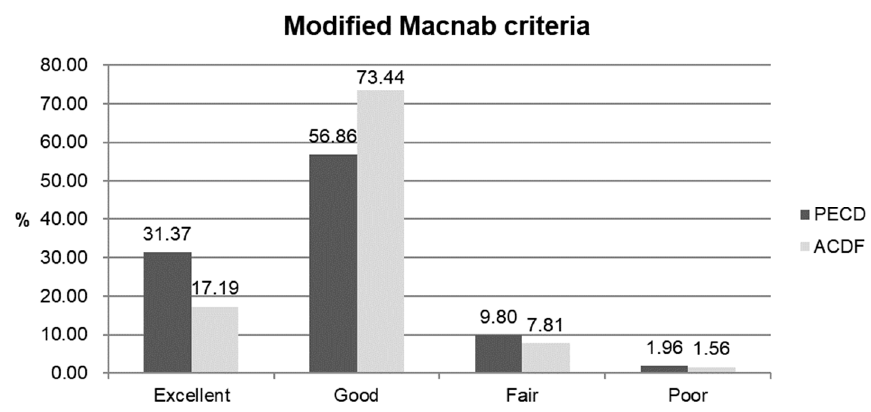
Figure 4. Global outcomes according to the modified Macnab criteria. An excellent or good outcome was observed in 45 of 51 patients (88.24%) in the PECD group and in 58 of 64 patients (90.63%) in the ACDF group. There were no significant differences between the groups. PECD, percutaneous endoscopic cervical discectomy; ACDF, anterior cervical discectomy and fusion.